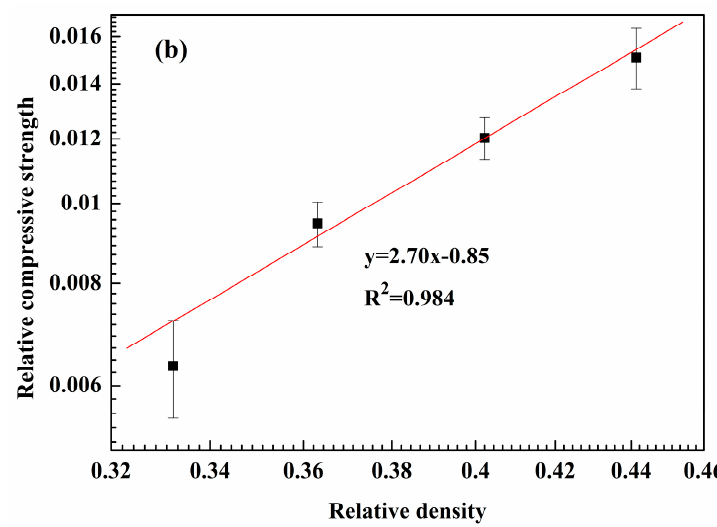
Figure 7. ( a ) Compressive strength and ideal compressive strength of the samples with different ratios of starting powders and deionized water; and ( b ) linear fitting of the relative compressive strength and relative density.